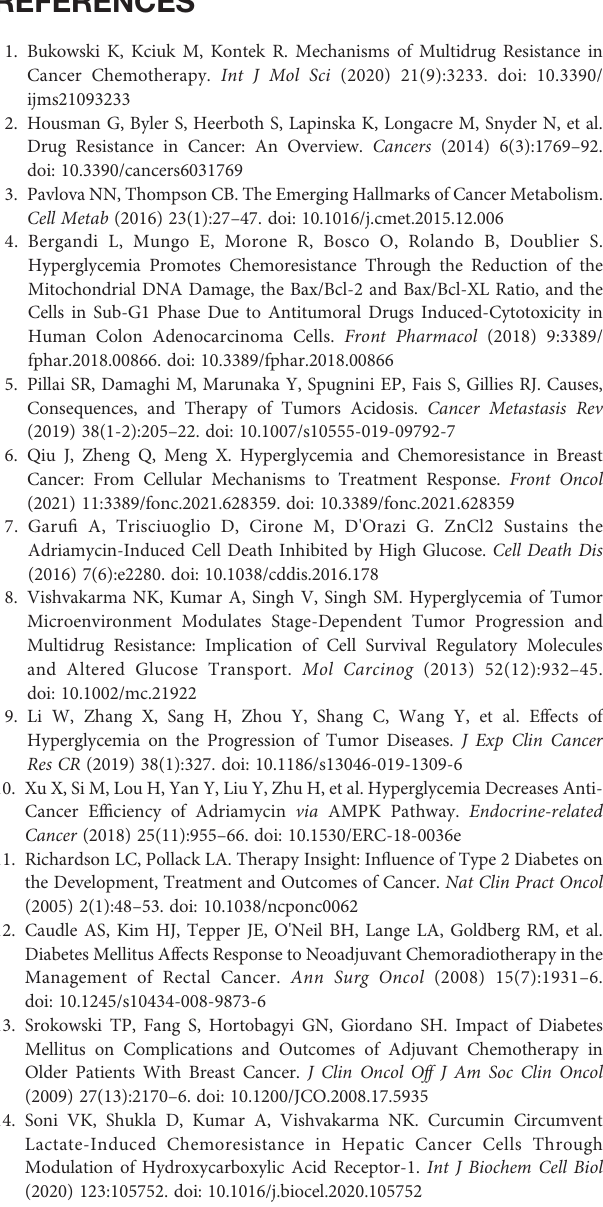
Supplementary Figure 3 | High glucose condition resisted anticancer drug- induced cell death in HepG2 cells. Dead and live population were enumerated in HepG2 cells incubated in NG or HG medium with increasing concentration of anticancer drugs. Ratio of dead and live cells was calculated for cell treated with doxorubicin (A) or methotrexate (B) . The values shown are Mean ± SD of three independent experiments conducted in triplicate. * p < 0.05, ** p < 0.01 vs values of cells incubated in NG medium. # p < 0.05, ## p < 0.01, ### p < 0.001 vs values of cells incubated in medium without anticancer